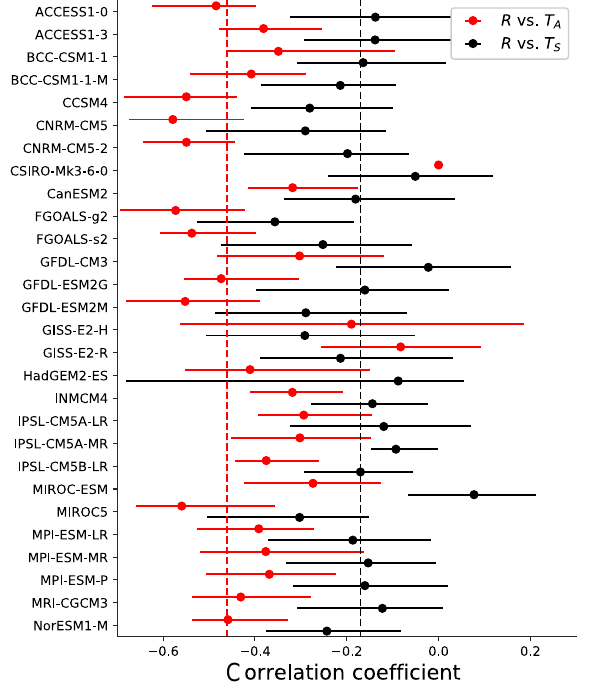
Figure 4. Correlation coefficients between (cid:49)R and temperature in CMIP5 control runs: black and red symbols represent the correla- tion with (cid:49)T S and (cid:49)T A , respectively. The dot is the average of the correlation coefficients from the 17-year segments of the model run; the bars indicate the maximum and minimum values from the control run. The dashed lines are the corresponding correlation co- efficients from the CERES regressions in Fig. 3.